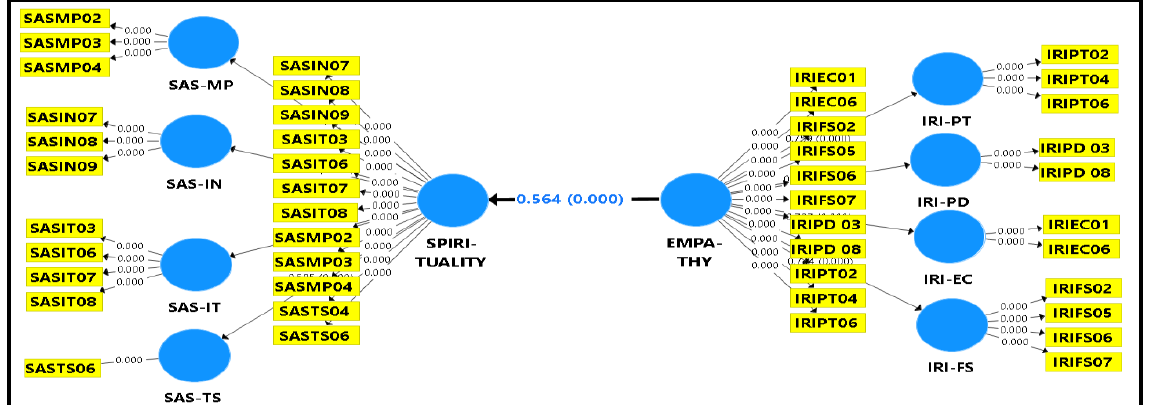
Figure 3. Empathy Affects